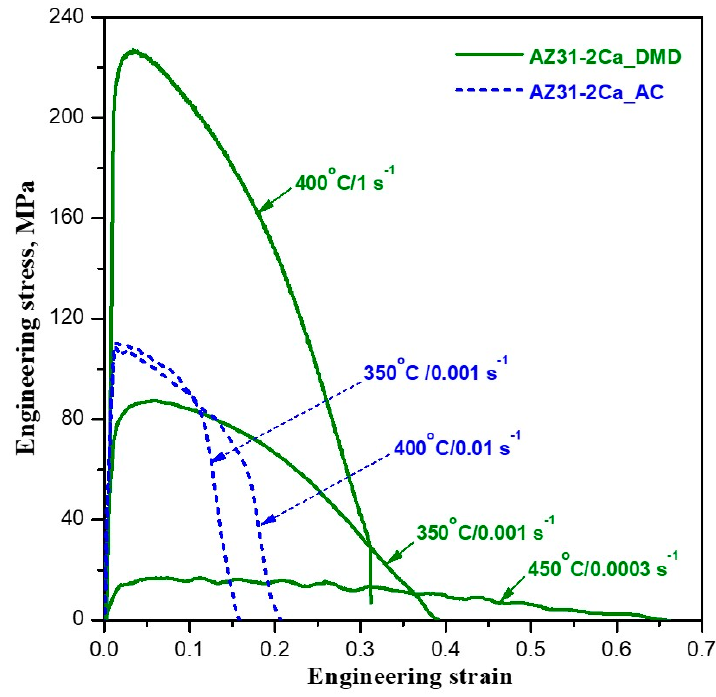
Figure 10. Engineering stress—Engineering strain curves obtained in tension on AZ31-2Ca alloy in AC and DMD conditions in different domains of processing maps.